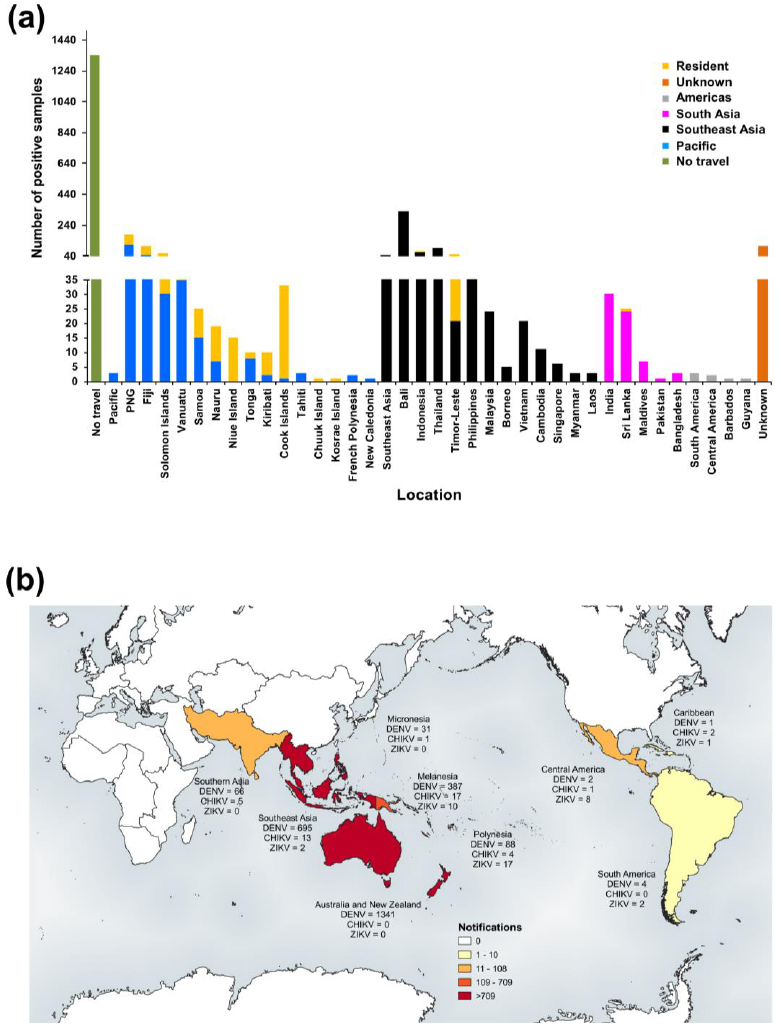
Figure 4. RT-rtPCR/RT-PCR-positive samples reported by PHV, Queensland between 2005 and 2017 by location (region travelled from or residence). Subregional classifications were taken from the United Nations Statistics Division at https://unstats.un.org/unsd/methodology/m49/. ( a ) Number of DENV RT-rtPCR/RT-PCR-positive samples. Allocations to specific locations or broader subregional classifications (which exclude specific location data) were dependent on the travel information available. Patients with no travel (no overseas travel outside Australia) and patients who did not travel to Australia (resident of that location) are shown separately, including cases from the Pacific Islands, Niue, Chuuk, and Kosrae. Corresponding summaries of CHIKV and ZIKV RT-rtPCR-positive samples based on location are shown in Supplementary Figure S2B,D, respectively). ( b ) Choropleth map of positive DENV, CHIKV, and ZIKV RT-rtPCR/RT-PCR samples (https://doi.org/10.6084/m9.figshare.6220481.v2) based on subregional classifications. Where a sample was positive for more than one virus (e.g., DENV-1 and DENV-2), the sample was only included in the map once ( n = 2). Three additional positive samples (two from the Pacific and one from the South Pacific) could not be allocated to the map subregions and were not included. Map was created using QGIS software version 3.0.1.